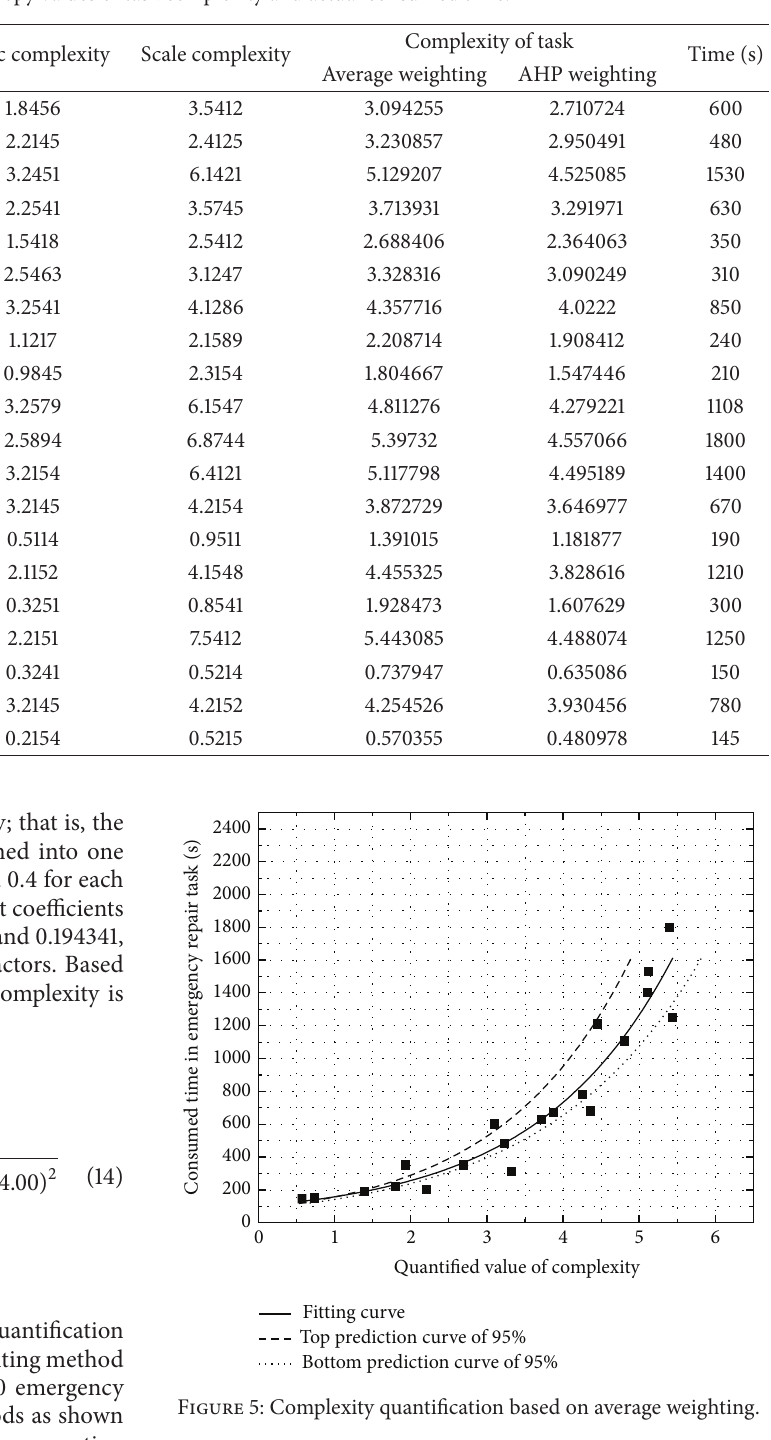
Table 3: Quantified entropy values of task complexity and actual consumed time.